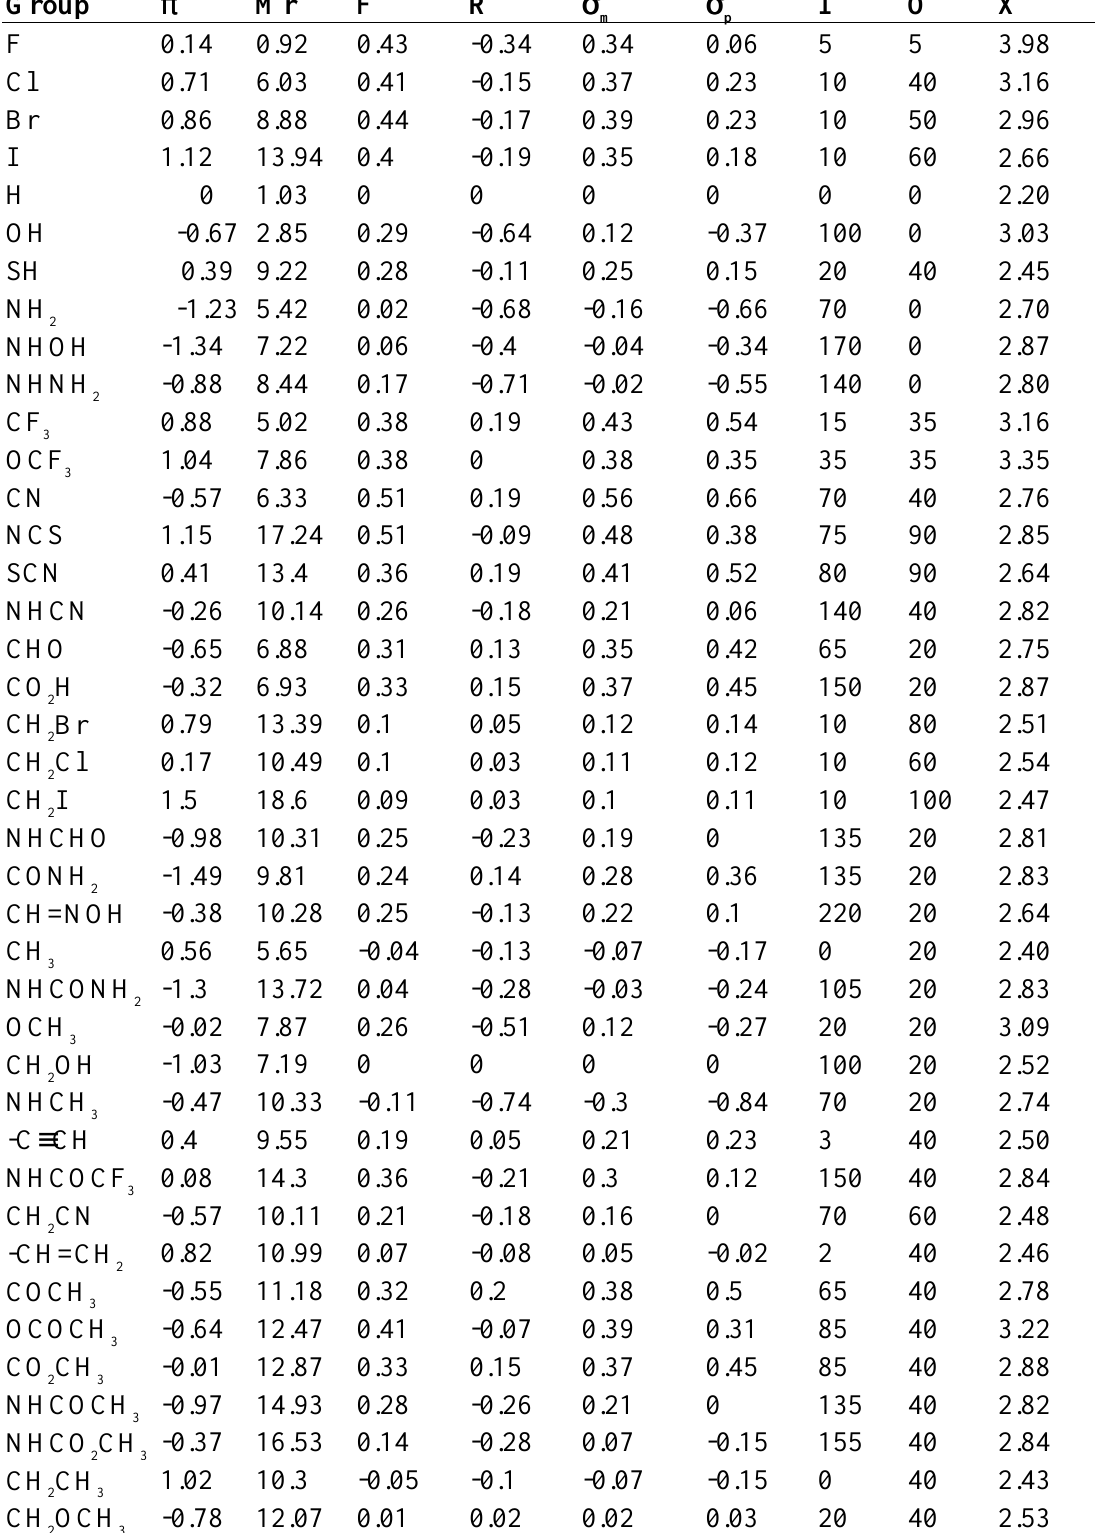
Table 2. Inorganic and organic property and other parameters of 50 common groups.